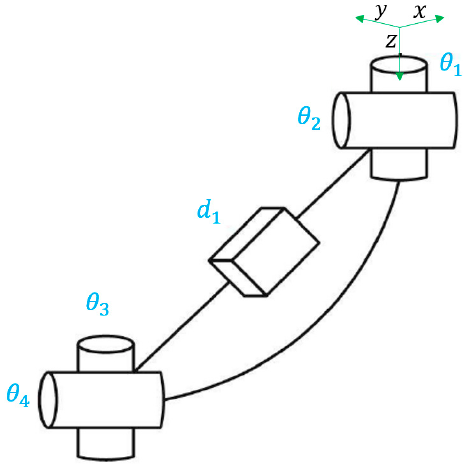
Figure 3. Hypothetical rigid link model of a fl exible robot. Adapted from [10].